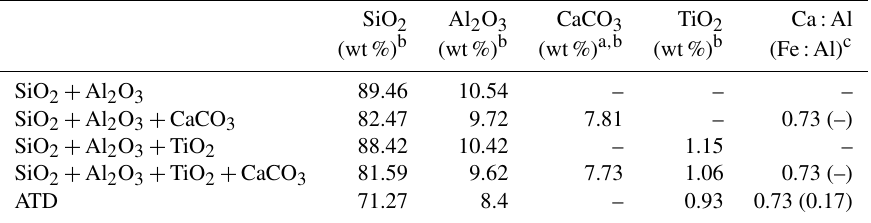
Table 1. Chemical compositions of mineral dust